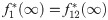
Rapid RD enable conditional treatment and infection control strategies that can select against resistance for obligate pathogens even with no biological costs of resistance.The minimal cost of resistance f*(D) that allows universal treatment without causing an increase in resistance is plotted (contour lines) against diagnostic delay D. The dashed vertical line indicates the longest diagnostic delay (D*) given which there is selection against drug 1 resistance while treating all cases. Three scenarios are shown: RD not available (No RD, contour plot of f1*(∞)=f12*(∞)); RD control of I1 only (RD (I1), contour plot of f1*(D)); and RD control of I12 (and trivially, I1) (RD (I12), contour plot of f12*(D)). Parameters (rates per day): γ0I=0.1, γ1I=γ2I=0.2,βI=0.2,Z1I=0.8, Z12I=0.8. RD, resistance diagnostics.